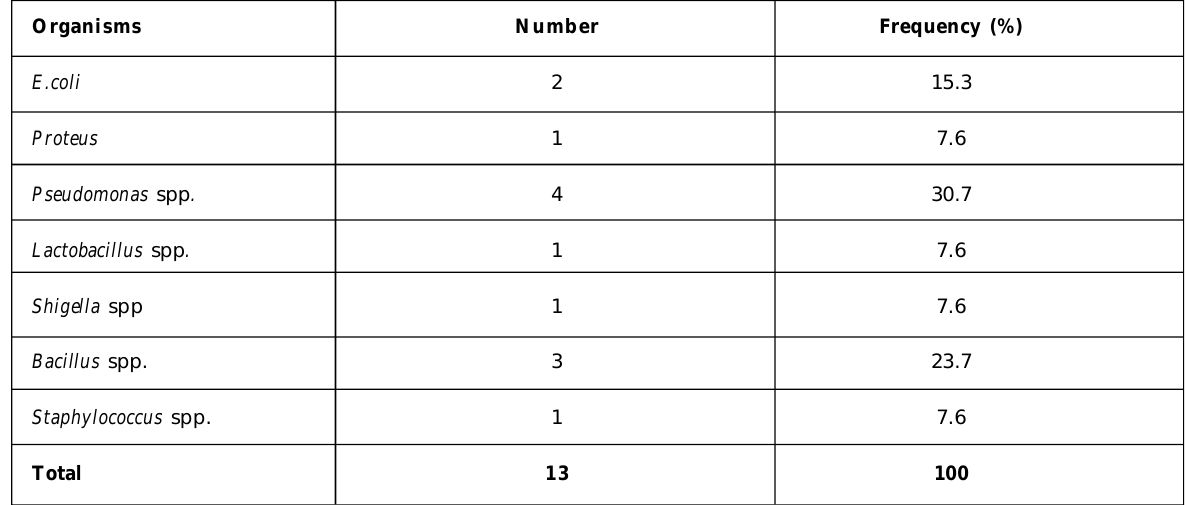
Table 3: Percentage distribution of aerobic bacterial isolates Organisms